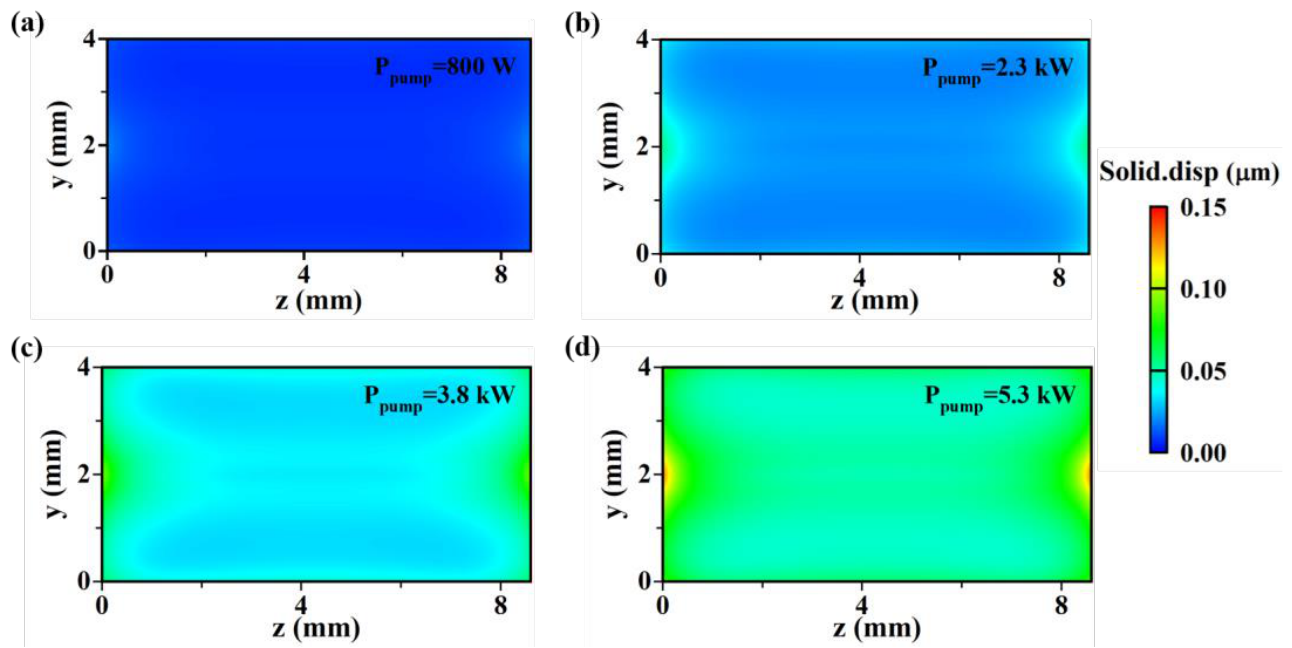
Figure 6. Cross-sectional thermal deformation distribution of diamond crystal at different output power levels, ( a ) 800 W, ( b ) 2.3 kW, ( c ) 3.8 kW, and ( d ) 5.3 kW.